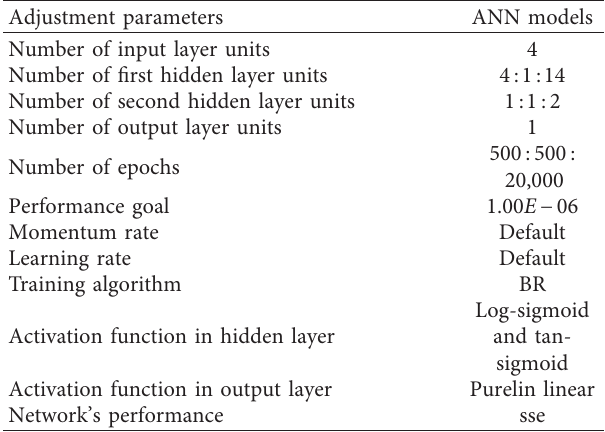
Table 4: The adjustment parameters used in the ANN